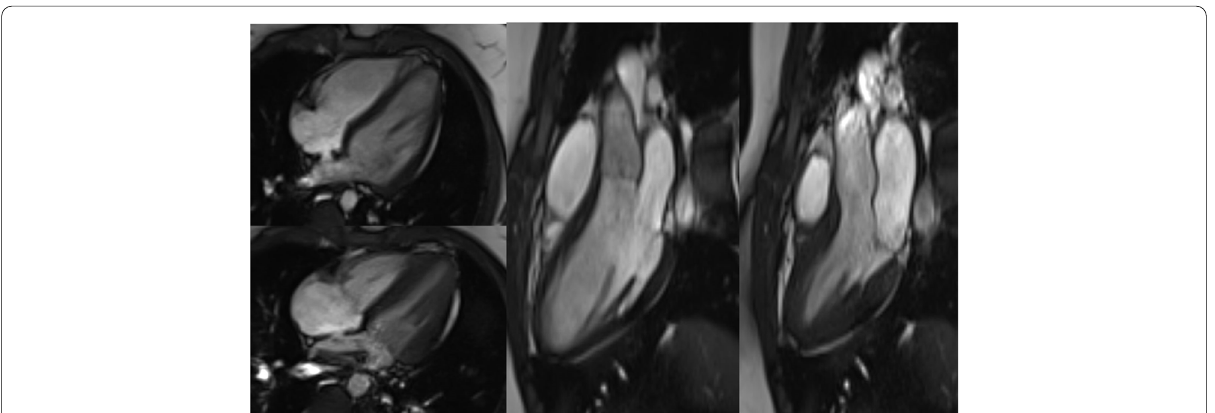
Fig. 5 (Functional imaging): assessment of cinematographic (“CINE”) images allows a rapid overview of global and regional functions comparable to echocardiography. Standard are planned projections in the long- and short-heart axis. Here, images of a 12-year-old girl with follow-up after multisystem inflammatory syndrome in children (PIMS) are presented: a 4-chamber view in diastole (left upper row) and systole (left lower row) and a 2-chamber view also in diastole (middle) and systole